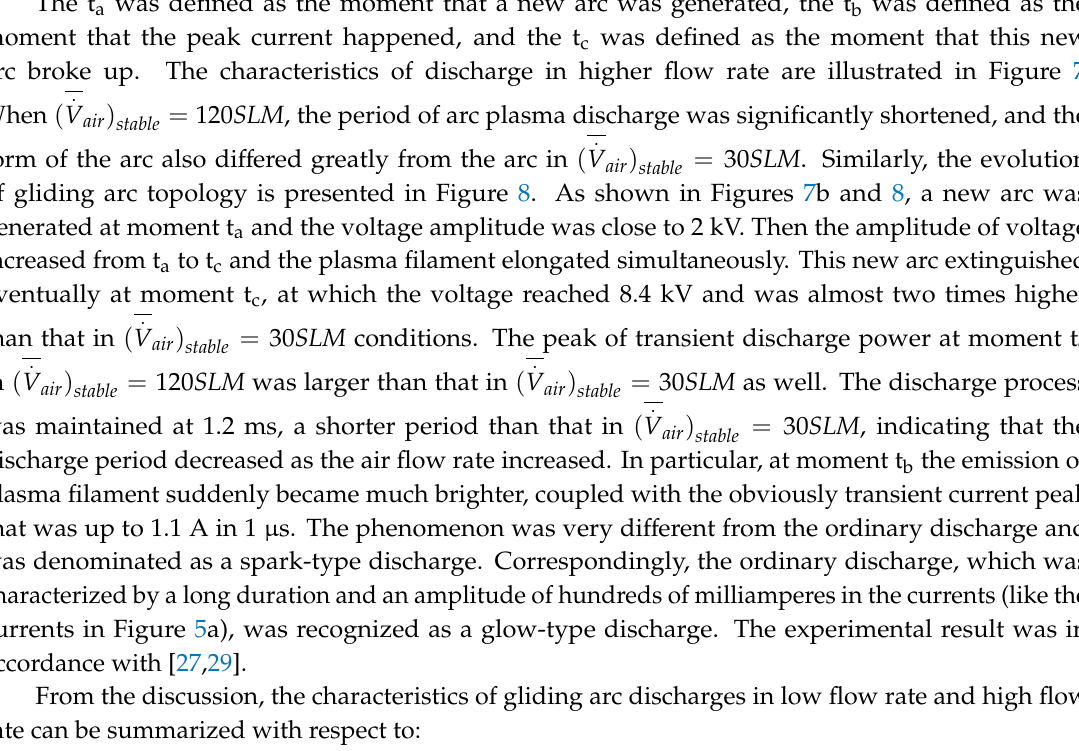
Figure 6. Simultaneous images of gliding arc topologies captured by a high-speed camera (sample rate: 30,000 fps, exposure time: 29.23 µ s) and two pictures taken using a regular digital camera when average flow rate in stable mode was 30SLM.